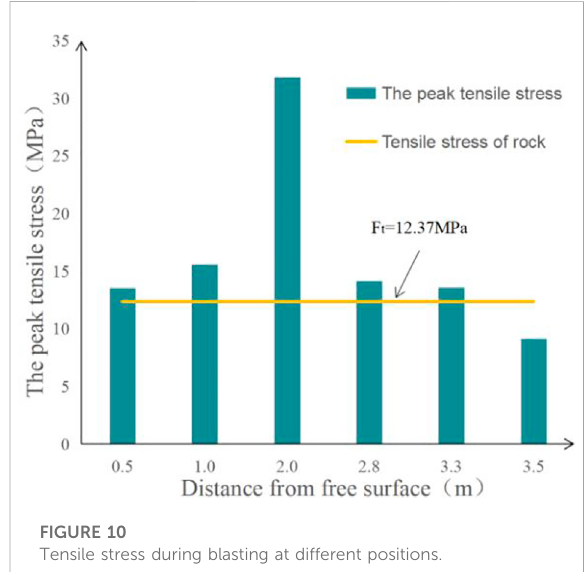
FIGURE 10 Tensile stress during blasting at different positions.